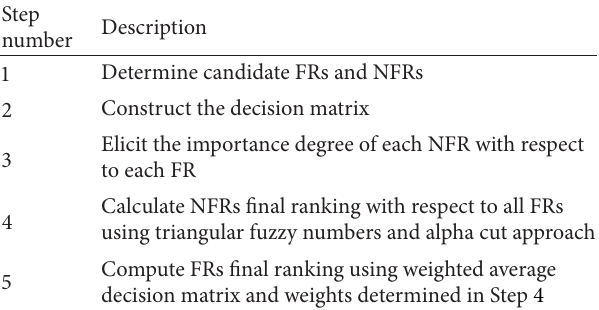
Table 1: Steps of IPA for integrating the prioritization of FRs and